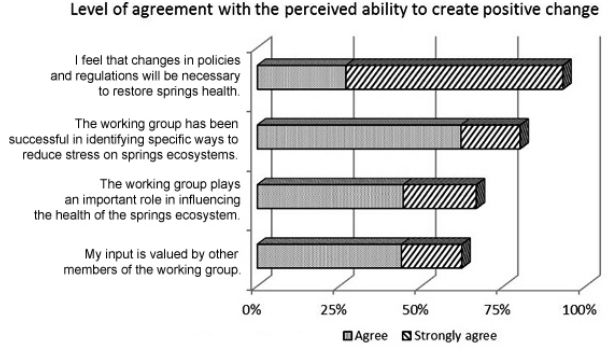
Fig. 3 . Respondent perceptions regarding meaningful